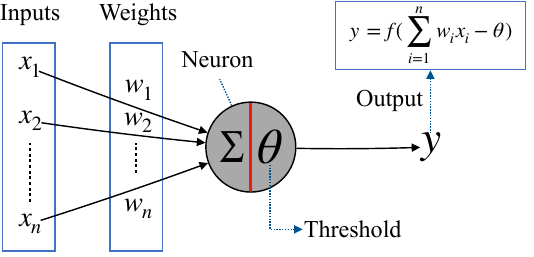
Figure 4. The structure of McCulloch-Pitts neuron